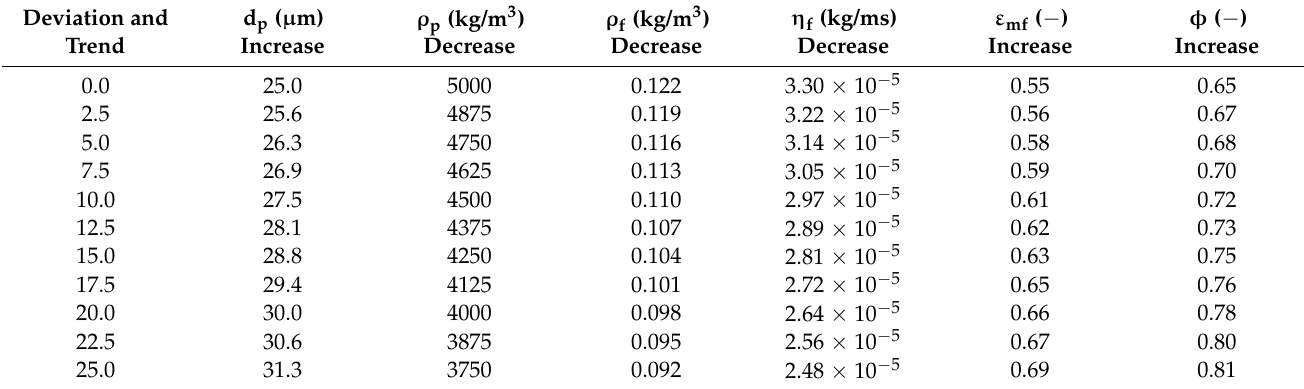
Table A5. Data for the sensitivity analysis of u mf including initial